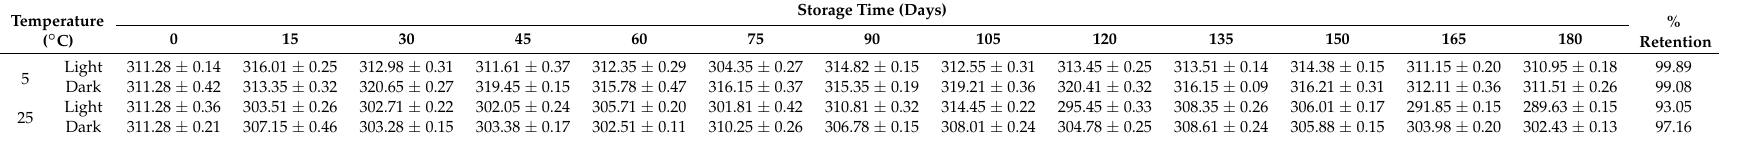
Table 1. Stability of total phenolic content (mg gallic acid equivalent/g) of dried Piper betle extract under different storage temperatures and light for six months 1